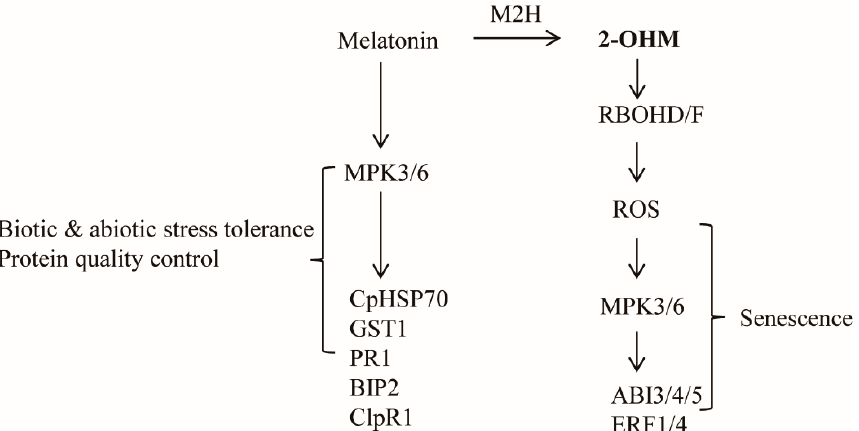
Figure 8. Proposed model of 2-OHM-mediated reactive oxygen species (ROS production and signaling pathway for senescence induction in arabidopsis. Melatonin is involved in defense responses against many biotic and abiotic stresses as well as in protein quality control, mediated by the MPK3/6 signaling pathway. Melatonin-induced genes included CpHSP70 , GST1, PR1, BIP2, and ClpR1 . Conversely, 2-OHM converted from melatonin by M2H induced ROS in an RBOHD/F-dependent manner, followed by the MPK3/6 signaling pathway, leading to the induction of many genes related to senescence signaling including ABI3, ABI4, ABI5, ERF1, and ERF4 .